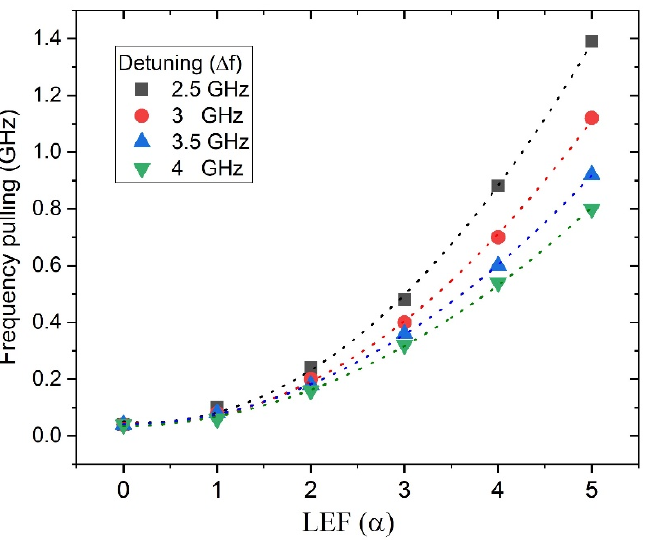
Figure 4. The dependence of frequency pulling on the LEF for different frequency detunings.